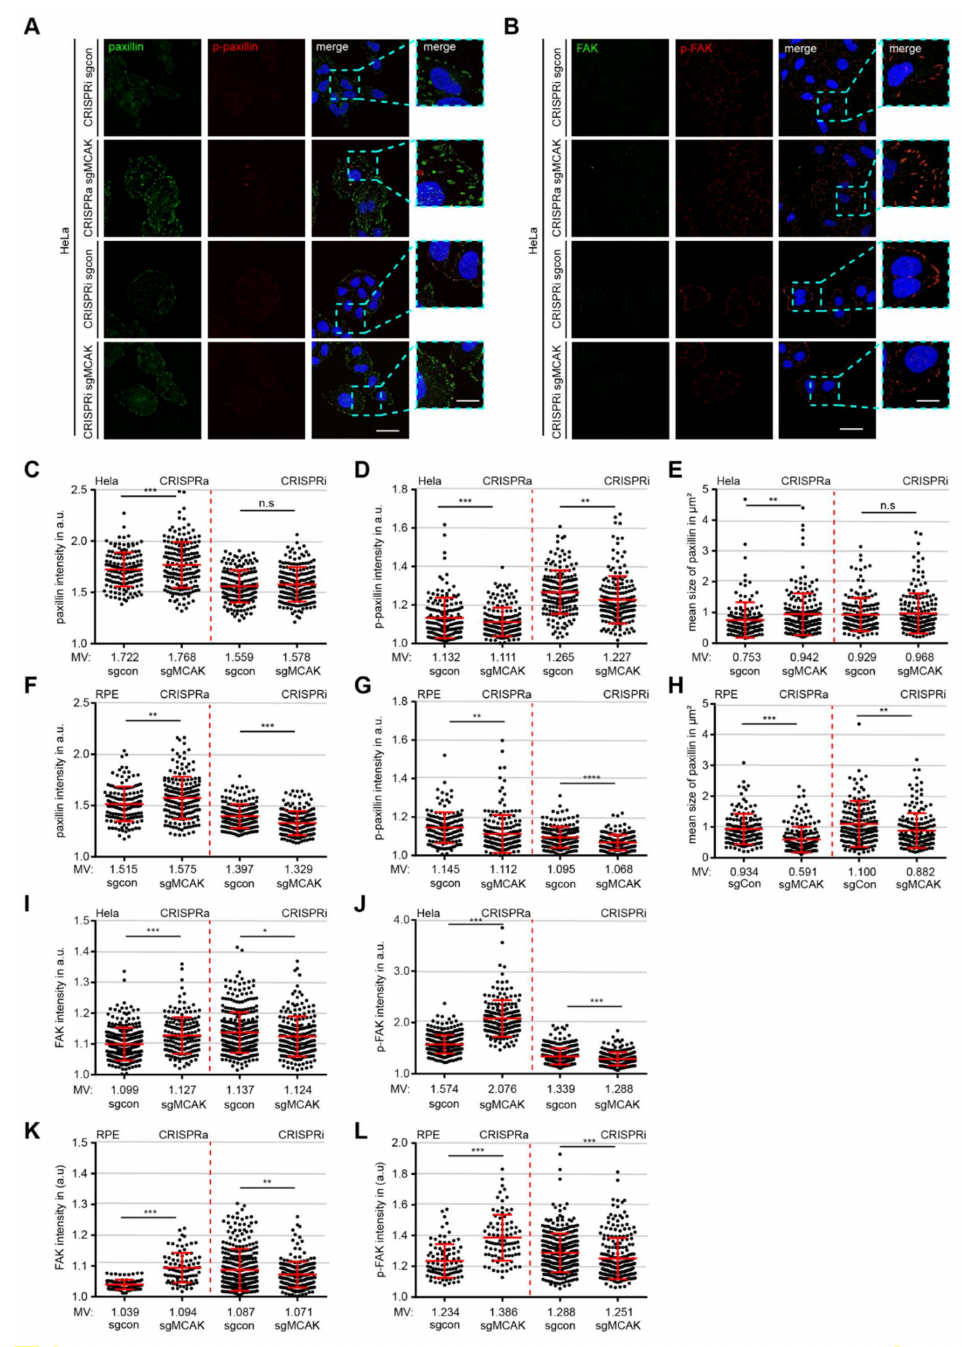
Figure 3. Interfering with the expression of MCAK deregulates FA proteins and their phosphorylation status ( A , B ) HeLa CRISPRi/a cells were stained for paxillin (green) and p-paxillin (red) ( A ), or FAK (green) and p-FAK (red) ( B ) for fluorescence microscopy. Representative images are shown. Scale: 12.5 µ m; inset scale: 5 µ m. ( C–H ) Quantification of the mean gray intensity of the outlined paxillin ( C , F ), p-paxillin ( D , G ) signals, and the signal size of paxillin ( E , H ) of HeLa and RPE CRISPRi/a cells (100 FAs measured in each experiment). The results are based on three independent experiments and presented as scatter plots showing mean ± SEM; a.u., arbitrary units. ( I–L ) Quantification of the mean fluorescence intensity of FAK ( I , K ) and p-FAK ( J , L ) signals of HeLa and RPE CRISPRi/a cells (100 FAs measured in each experiment). The results are based on three independent experiments and presented as scatter plots showing mean ± SEM. Unpaired Mann–Whitney U test was used. * p < 0.05, ** p < 0.01, and *** p < 0.001. Abbreviation: n.s.: not